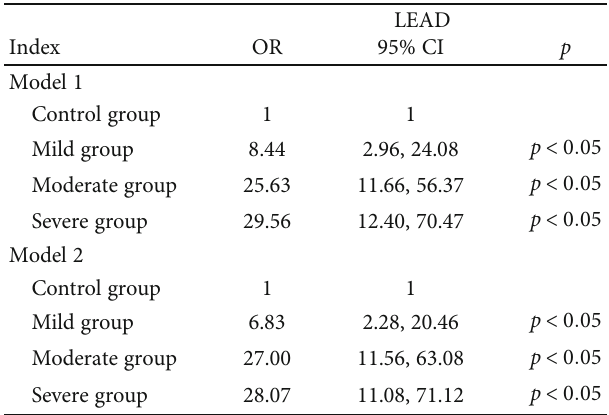
Table 4: Multivariate logistic regression results of OSAHS and LEAD in patients with